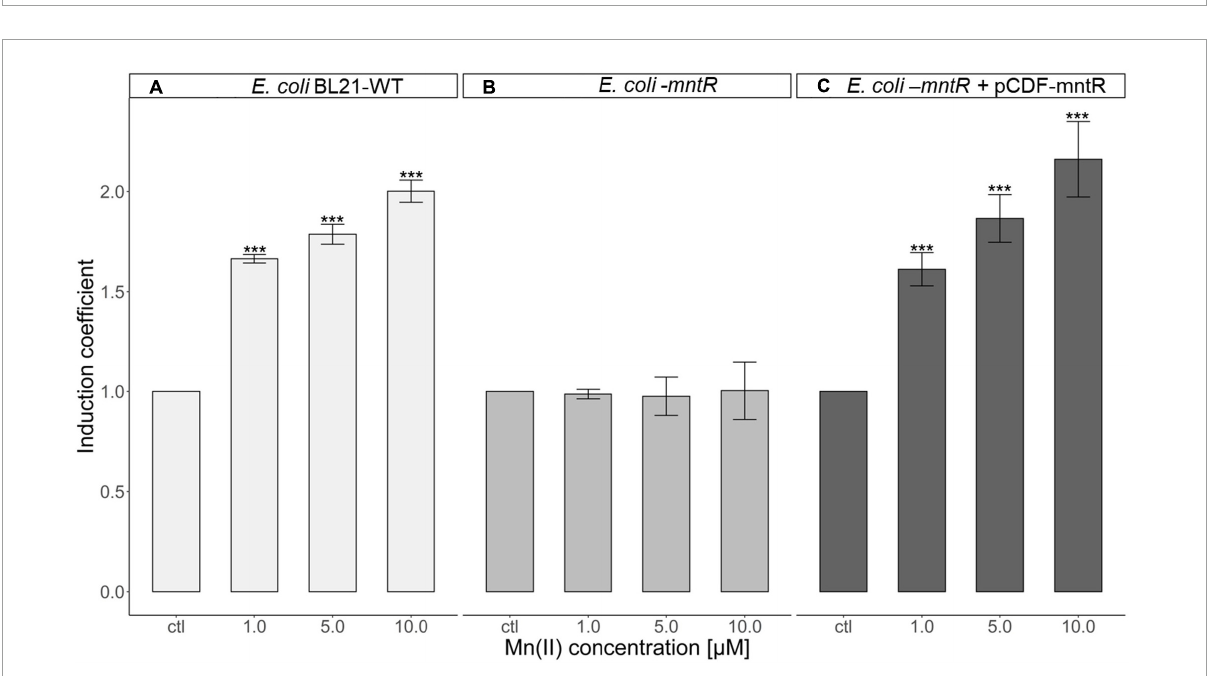
FIGURE4 Role of MntR in Mn(II)-sensing Escherichia coli cell-based biosensor harboring pMntS-eGFP. (A) Mn(II) response of E. coli WT harboring pMntS-eGFP, (B) , E. coli-mntR harboring pMntS-eGFP, and (C) E. coli-mntR harboring pMntS-eGFP/pCDF-MntR WT. The repression of egfp under P mntS was prevented by mntR deletion and restored by introducing recombinant MntR. The biosensors were exposed to Mn(II) for 2 h. The data was obtained from more than three times of replicated experiments. The asterisks indicate that the treatment values were higher than the control values (Dunnett’s test, *** p <